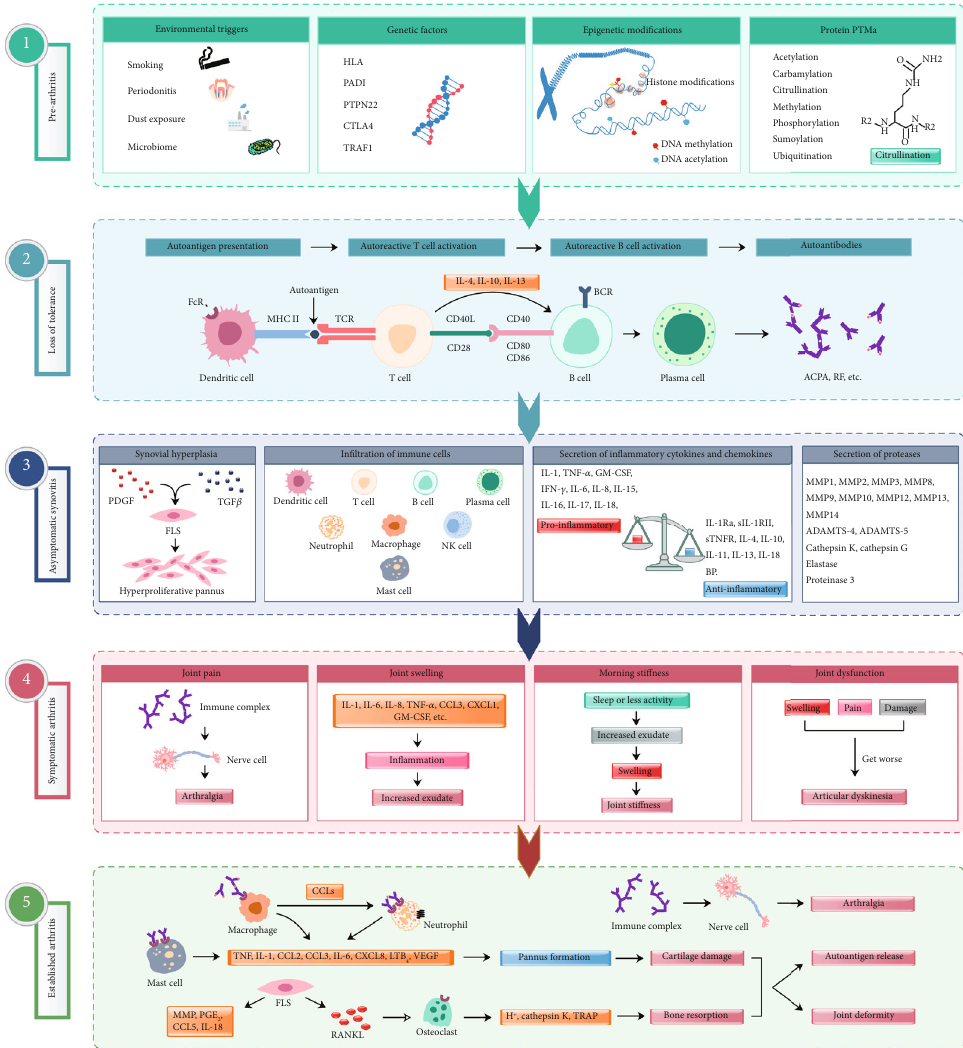
Figure 1: Di ff erent phases in RA pathogenesis. (1) Genetic, epigenetic, and environmental factors contribute to arthritis progression. Multiple environmental risk factors (for example, smoking, pollutants, or microbes), when come in contact with the mucosal sites, are most likely responsible for causing local in fl ammatory events and immune system activation inducing epigenetic modi fi cations and protein posttranslational modi fi cations (PTMs) [59], before crossing the threshold to trigger disease in genetically vulnerable people. (2) Dendritic cells presenting altered self or related peptides to T cells (breakdown of tolerance mechanisms) leads to the activation of T and B cells e ff ectuating synthesis of cytokines and autoantibodies. Progressively, these autoantibodies are produced more and more, which recognize several neoepitopes by the process of epitope spreading, and gets overt during the onset of the clinical disease [1]. (3) Disease development involves autoimmune responses against both posttranslationally modi fi ed and unmodi fi ed self-antigens, which starts many years before the subclinical synovitis and appearance of clinical symptoms [60]. (4) Autoantibodies induced during this preclinical phase can also be responsible for bone erosion and pain. Before the onset of in fl ammation, these alterations could reduce overall functions of the joints. After the autoantibodies start binding to di ff erent epitopes and form immune complexes, in fl ammation in the synovium and development of arthritis ensue. (5) Antibody-induced cartilage and bone changes, if minor, resolve without any considerable damages. However, if left untreated or in the presence of continuous external stimuli, these changes can give rise to chronic in fl ammation, joint destruction, and disability [59]. Arthritis is associated with both local as well as systemic pathological manifestations. ACPA: anticitrullinated protein antibody; ADAMTS: a disintegrin and metalloproteinase with thrombospondin motifs; BCR: B cell receptor; CCL: c-c motif chemokine ligand; CXCL: C-X-C motif chemokine ligand; CTLA4: cytotoxic T-lymphocyte-associated protein 4; FcR: Fc receptor; FLS: fi broblast-like synoviocytes; GM-CSF: granulocyte-macrophage colony-stimulating factor; HLA: human leukocyte antigen; IFN- γ : interferon gamma; IL: interleukin; IL-1Ra: interleukin-1 receptor antagonist; IL-18BP: interleukin-18-binding protein; LTB : 4 leukotriene B4; MMP: matrix metalloproteinase; MHC II: major histocompatibility complex class II; NK cell: natural killer cell; PADI: peptidyl arginine deiminase; PDGF: platelet-derived growth factor; PGE : prostaglandin E2; PTPN22: protein tyrosine phosphatase 2 nonreceptor type 22; RANKL: receptor activator of nuclear factor kappa B ligand; RF: rheumatoid factor; sIL-1RII: soluble interleukin 1 receptor II; sTNFR: soluble tumor necrosis factor receptors; TCR: T cell receptor; TGF β : transforming growth factor β ; TNF- α : tumor necrosis factor α ; TRAF1: TNF receptor-associated factor 1; VEGF: vascular endothelial growth